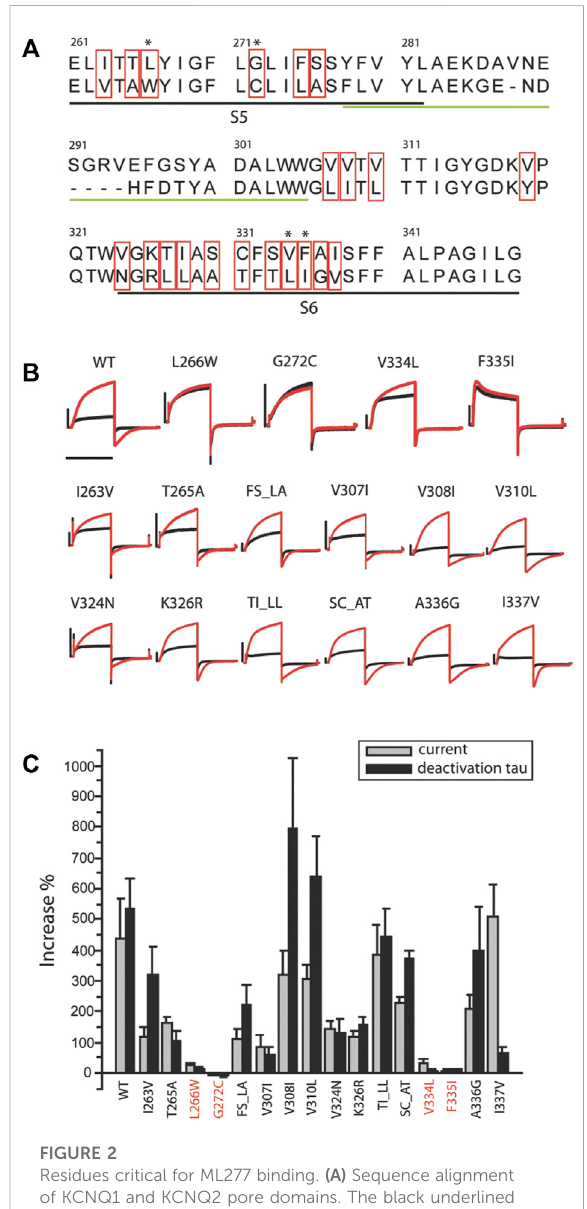
FIGURE 2 Residues critical for ML277 binding. (A) Sequence alignment of KCNQ1 and KCNQ2 pore domains. The black underlined residues are located in the S5 and S6 transmembrane domains. The green underlined residues were excluded by chimera C2 and are unlikely drug sites for ML277. The residues in red boxes are not conserved between KCNQ1 and KCNQ2 and are potential sites critical for ML277 binding. (B) KCNQ1 residues L266, G272, V334,andF335areresponsibleforML277effects.Currenttracesin the top row show the effect of ML277 on wt and the loss of effect on L266W, G272C, V334L, and F335I KCNQ1. The middle and lower rows show the effect of ML277 on other mutant channels. The black and red traces represent recording in control condition andwith 10uMML277, respectively. (C) Bargraphsummarizingthe effect of ML277 on current amplitude (grey bar) and deactivation kinetics (black bar) of all the mutants tested. The scale bar in panel B is a 1 s time